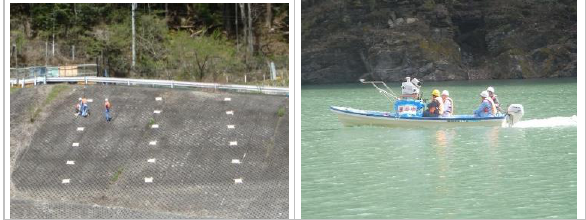
Figure 9. Accuracy evaluation of the developed boat-loading system